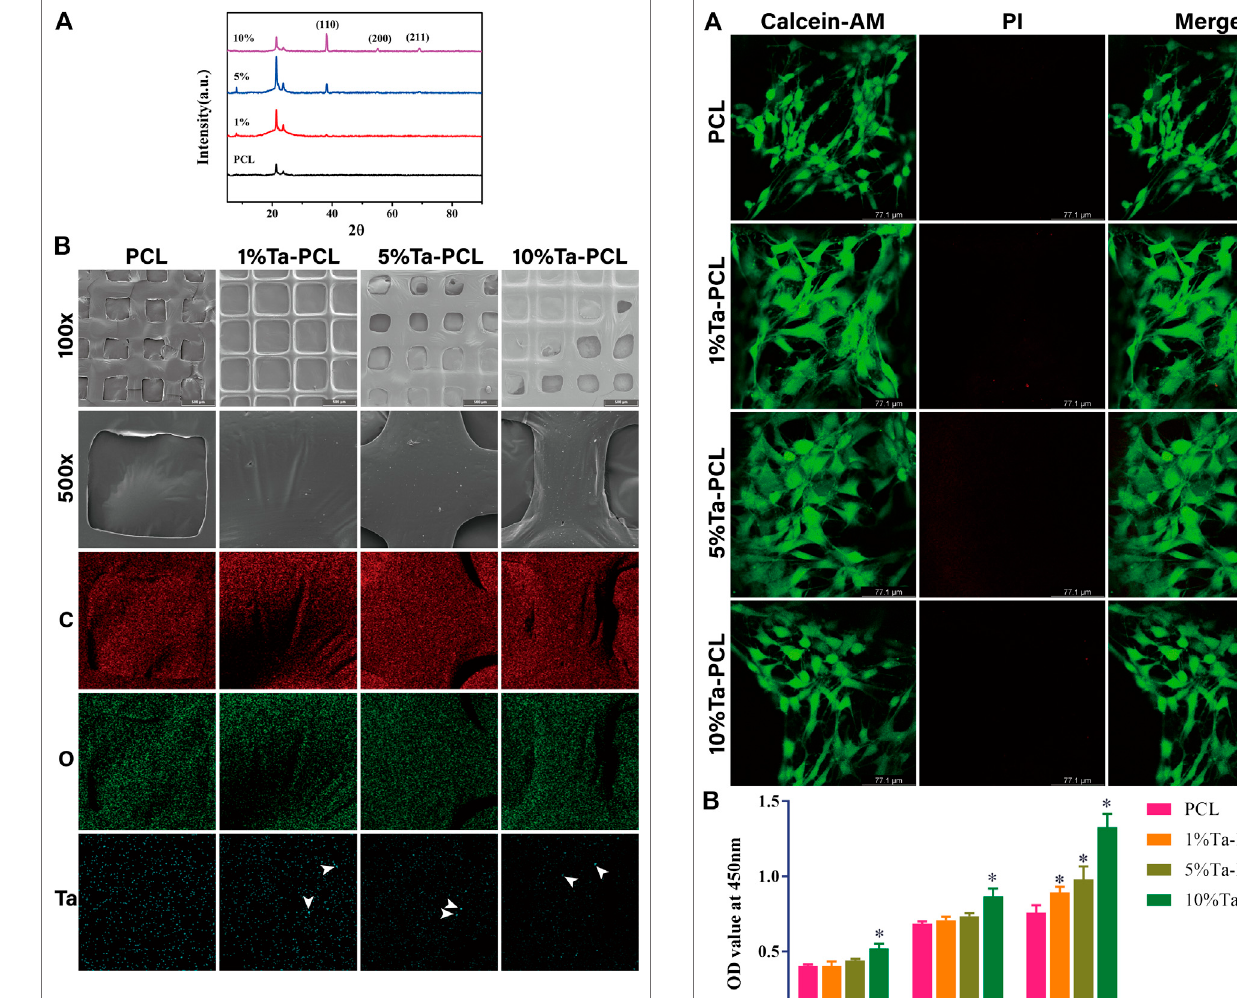
FIGURE 2 | Physico-chemical characterization of Ta/PCL scaffold. (A) XRD spectra. (B) EDS spectra. The arrows represent tantalum nanoparticles.